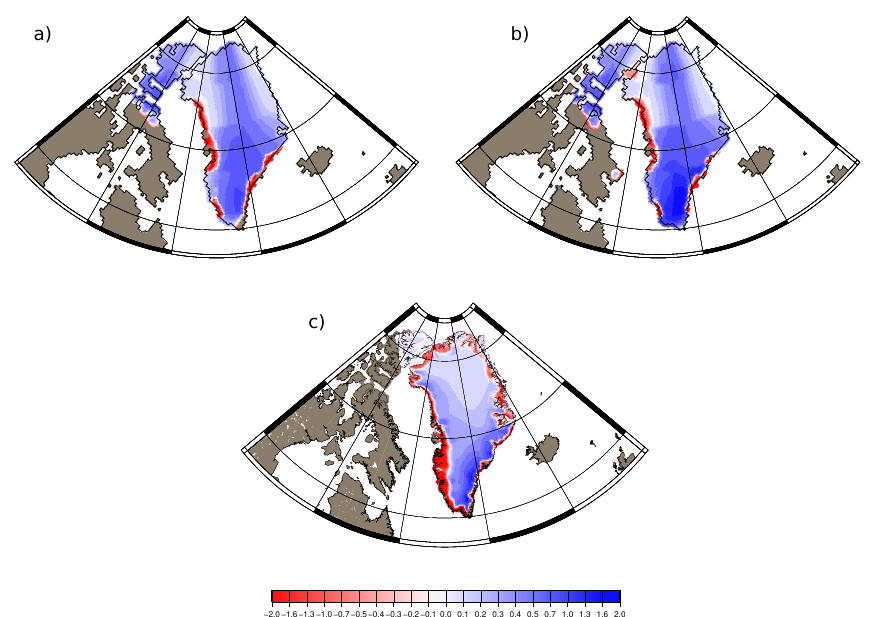
Figure 11. Comparison of simulated surface mass balance for the Greenland ice sheet. (a) : SNOW; (b) : PRECIP (both for simulated pre- industrial conditions). (c) : results from the MAR regional climate model at 25km resolution forced by reanalyses over the period 1979–1988 from Fettweis et al. (2011).